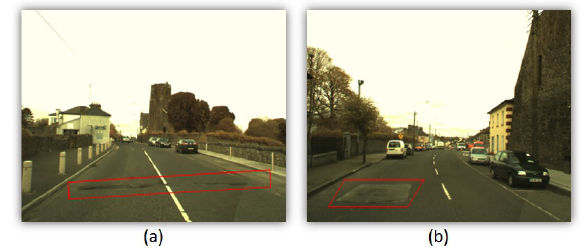
Figure 4: Digital image of (a) first and (b) second section of urban road with roughness regions indicated in red boxes.